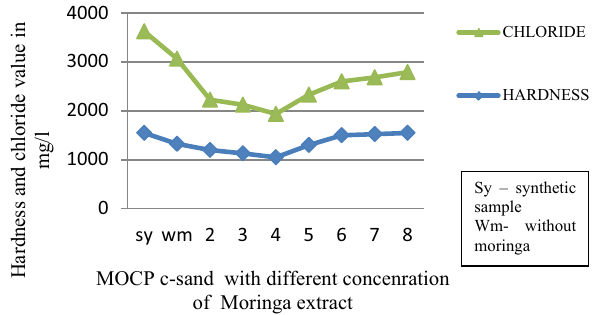
Fig. 2 Removal of hardness and chloride using MOCP c-sand of various concentrations of MOCP